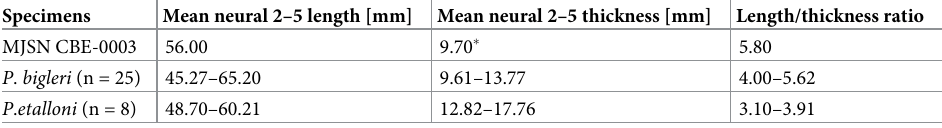
Table 2. Measurements of the neural elements of MJSN CBE-0003 and selected specimens of Plesiochelys bigleri and Plesiochelys etalloni . See Pu¨ntener et al. [11] for original data on P . bigleri and P . etalloni .